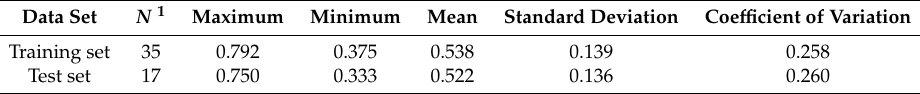
Table 3. Descriptive statistics of forest spatial structural parameters from 52 sampling points.